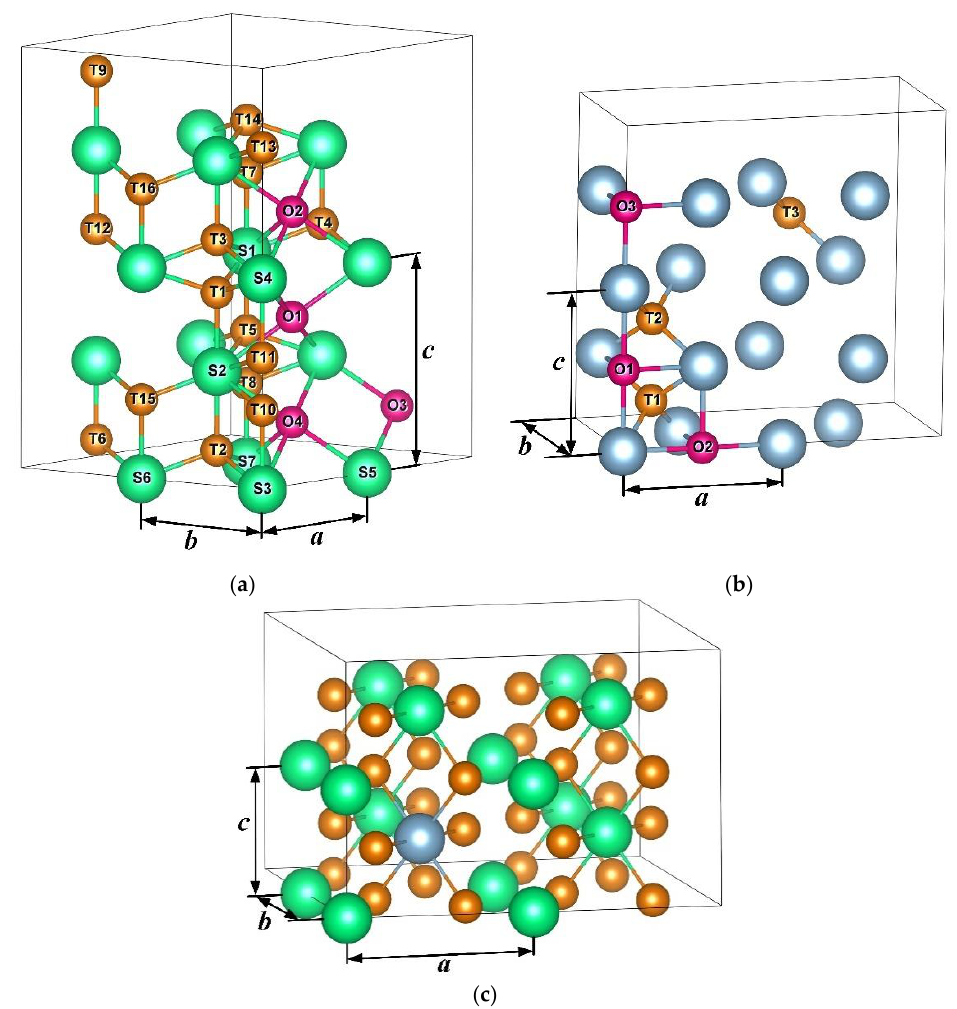
Figure 1. ( a ) Positions of the considered substitution sites for Al atoms and positions of the considered interstitial sites for H atoms in the hcp Mg 16 supercell; ( b ) positions of the considered interstitial sites for H atoms in the fcc Al 16 supercell; ( c ) positions of the considered substitution sites for Al atoms in the bct Mg 16 H 32 supercell. Magnesium atoms are green, aluminum atoms are blue, tetrahedral sites are orange, and octahedral sites are pink.